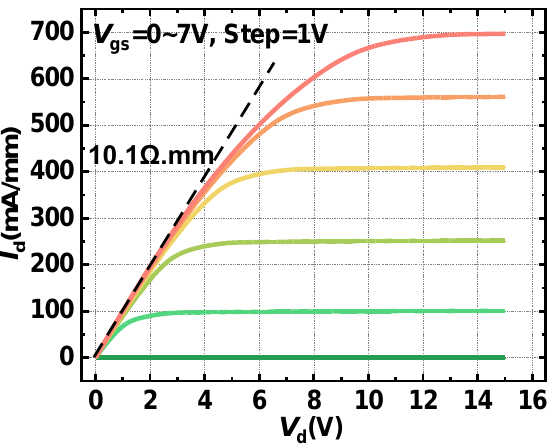
Figure 8. Output characteristics of the HG-UTB HEMTs.